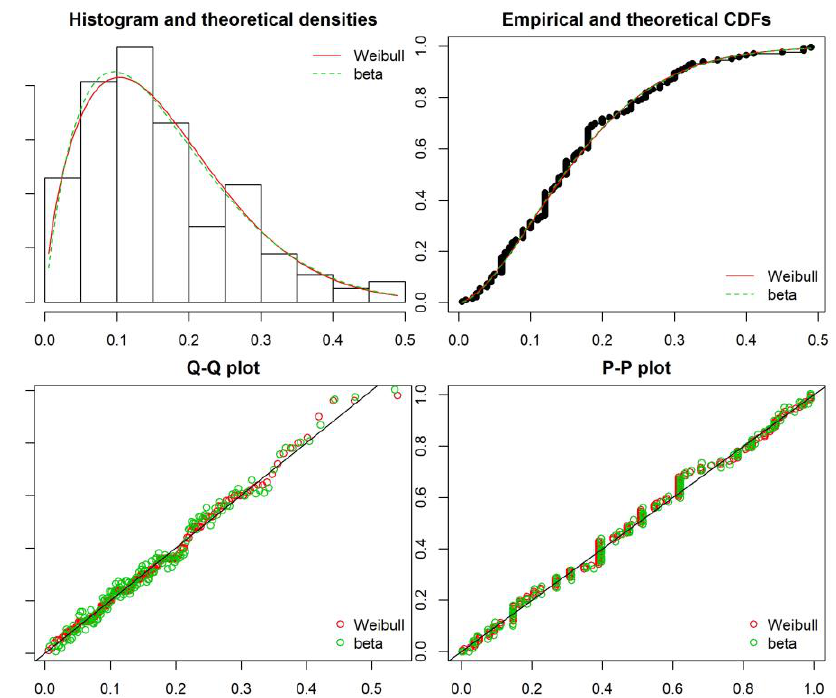
Figure 3. The assessment of goodness of fit of the empirical data of S 6 state to the Weibull and Beta distributions.